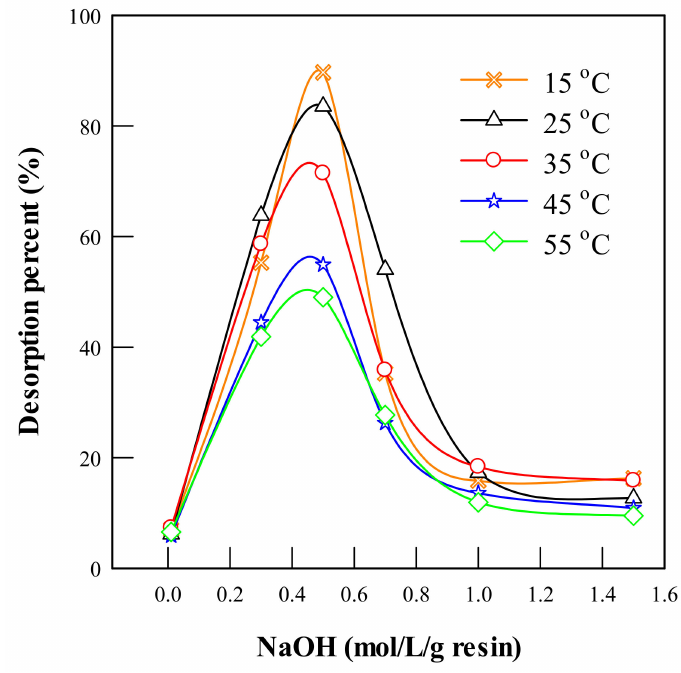
Figure 10. Effect of NaOH on the equilibrium desorption of ectoine using Dowex ® HCR-S at different temperatures (saturated resin: 1 g, NaOH solution: 10 mL, time: 8